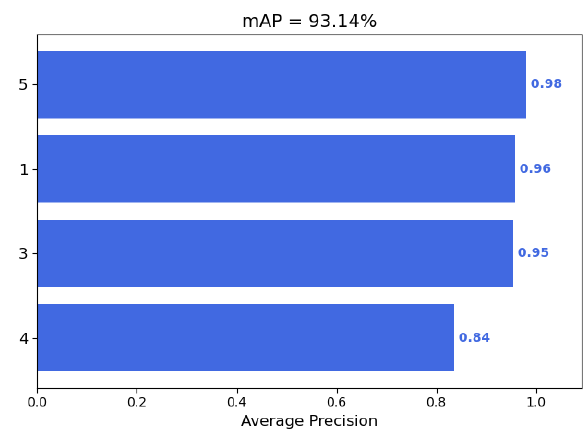
Figure 12. In the lightweight YOLOv4, with MobileNetv1 as the backbone network, the AP values of each category of UAVs are presented in the bar graph, and the final mAP is